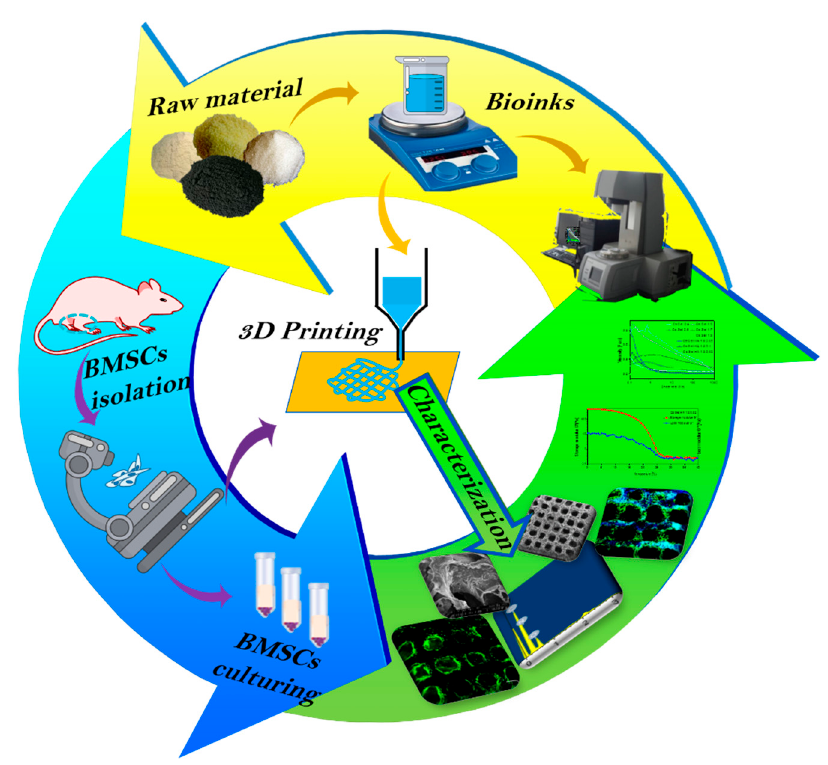
Figure 1. Schematic illustration of the general study design. Yellow area: Preparation of Cs/Gel/HA/GR bio-inks and production of scaffolds using 3D bio-printing. Green area: Characterizations of Cs/Gel/HA/GR cartilage scaffolds using scanning electron microscope (SEM) and live/dead staining of cells.